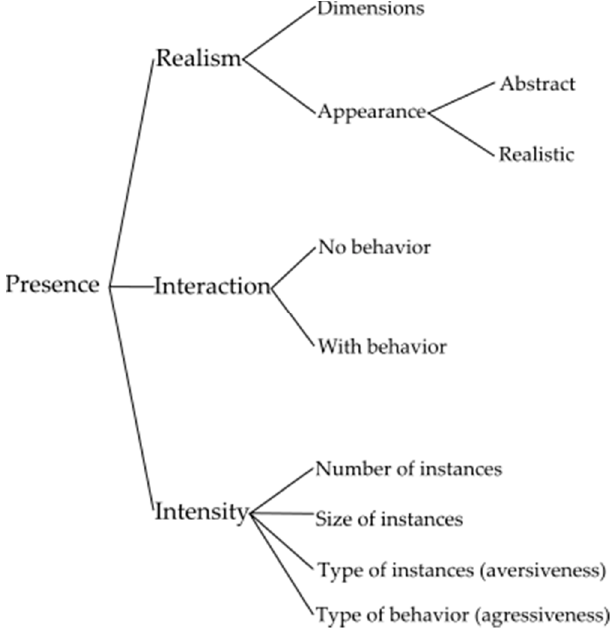
Figure 3. Proposed Taxonomy of factors that affect the experience of use of ARET systems for small- animal